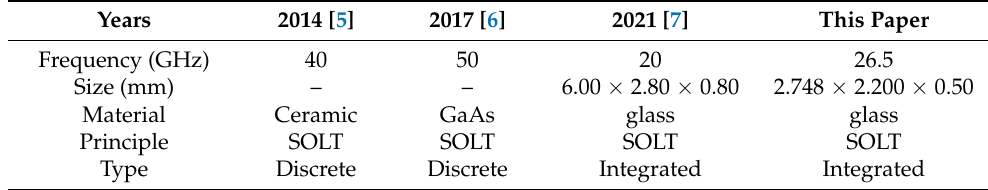
Table 4. Comparison with previous